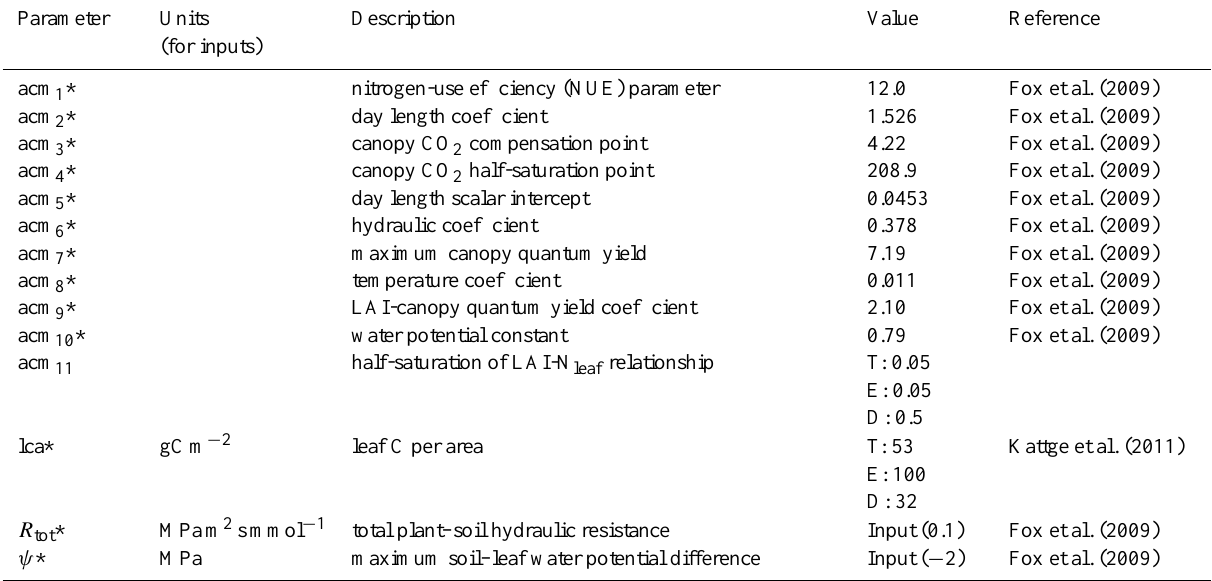
Table 3. Photosynthesis parameters (acm 1 − 11 ) for the aggregated canopy model (ACM), and fixed inputs (final three values in the table), used to determined carbon fixation in